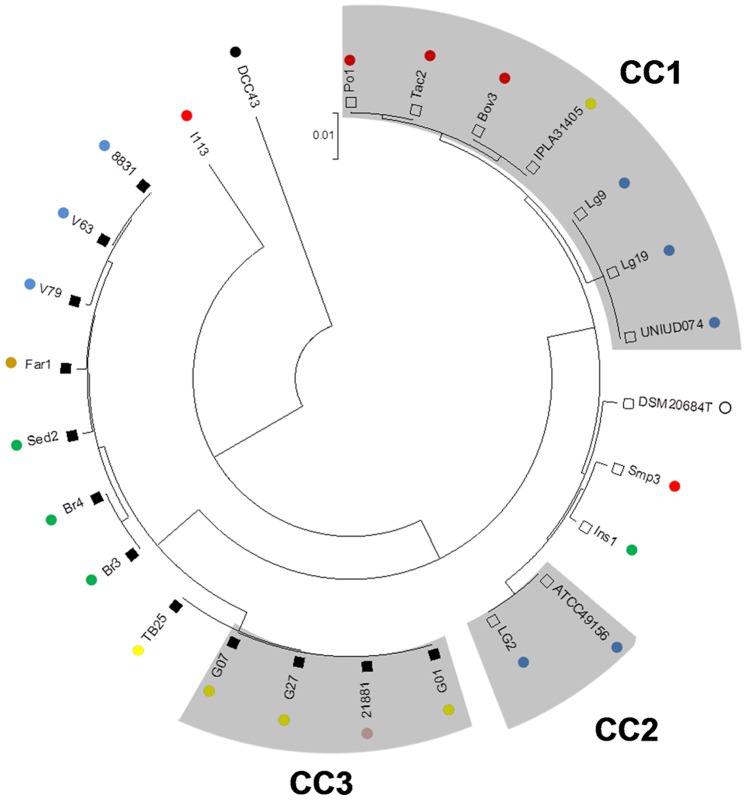
Phylogenetic relationships between L. garvieae strains.The unrooted neighbor-joining tree (bootstrap 1000, Kimura 2-parameter model) was constructed from the 5713 bp concatenated DNA sequences of the seven loci (als, atpA, tuf, gapC, gyrB, rpoC and galP) of L. garvieae. Open and closed squares correspond to subgroups SB and SA, respectively. Strain origin is indicated by color code: green = vegetables, brown = cereals, red = meat, yellow = dairy, blue = fish, pink = human, black = animal intestine, white = mastitic cow. Grey shadows represent CCs.